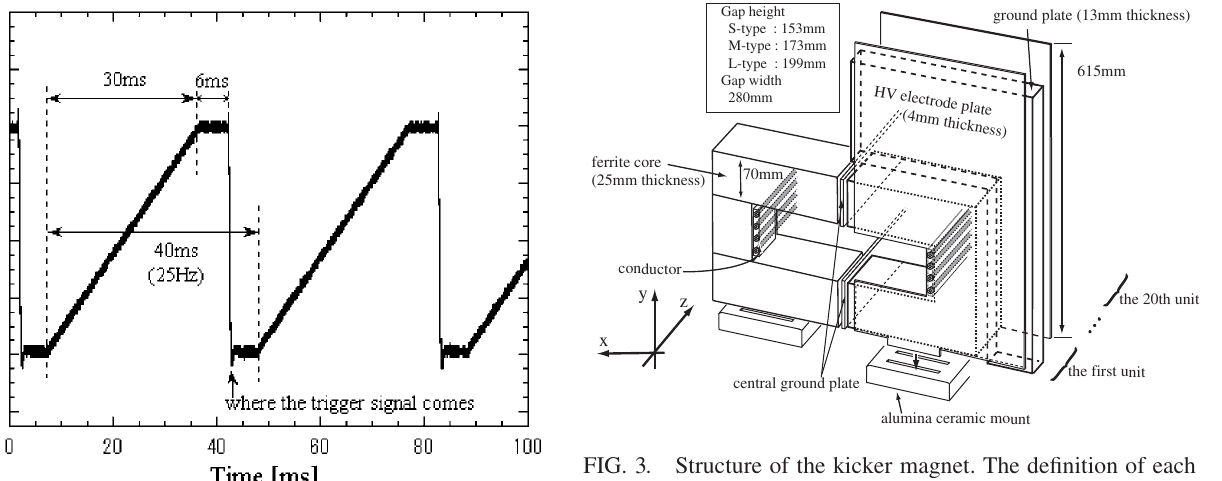
FIG. 3. Structure of the kicker magnet. The definition of each axis is also shown.